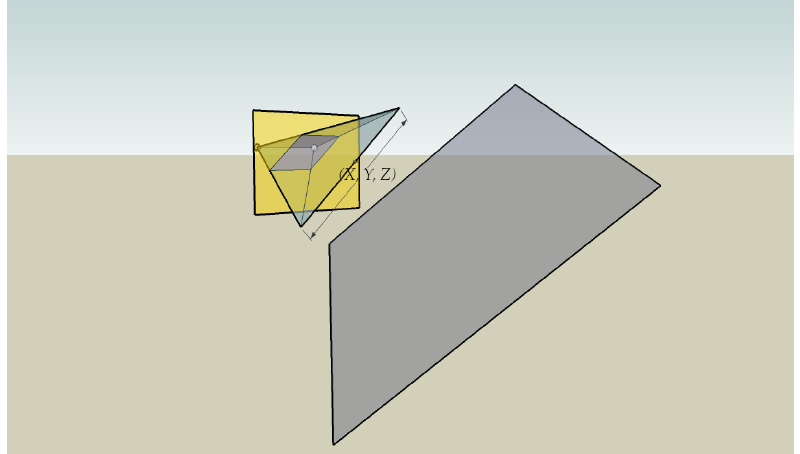
Figure 2. The arbitrarily oriented plane P (in gray) is represented in the image plane (in yellow). The spheres behind the image plane represent the optical centers of the left and right cameras,